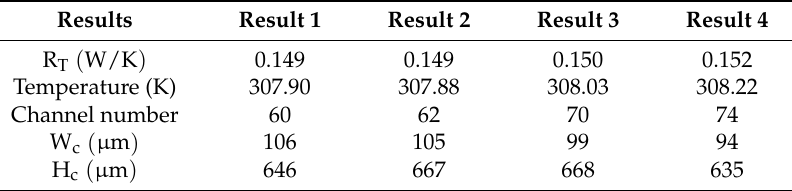
Figure 8. Optimal results of micro channel heat sink with channel number from 60 to 80. Table 3. Optimal results of the single objective function in Case 1. Table 3. Optimal results of the single objective function in Case 1.